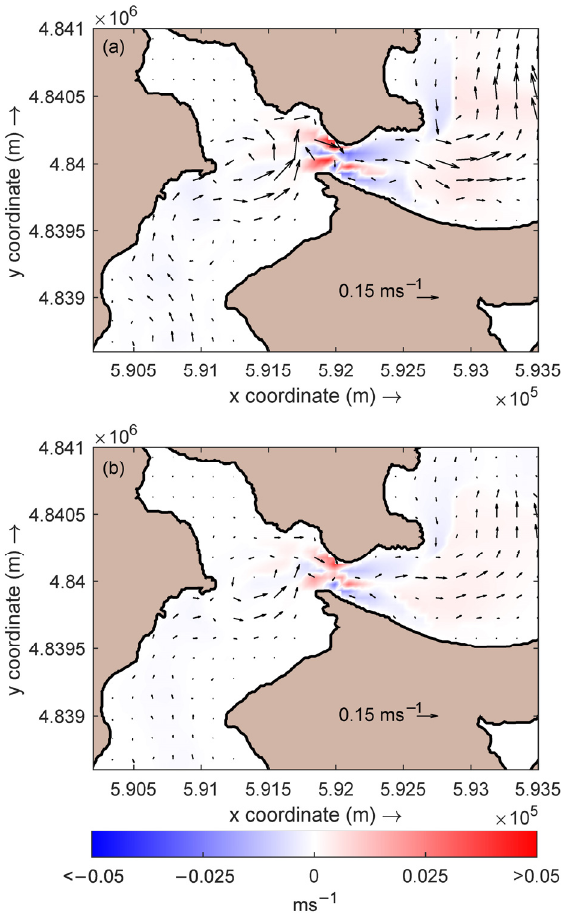
Figure 11. Residual flow pattern in Ria de Ortigueira under case study CS6 conditions (vectors); differences in the residual flow magnitude between altered flow and reference situation (CS6–CS2) (colour map). ( a ) Surface layer; ( b ) bottom layer.